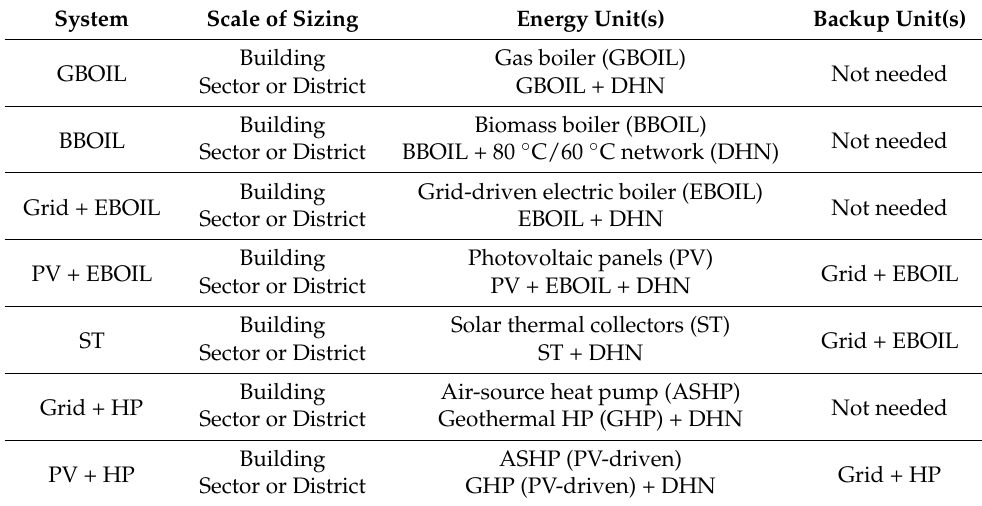
Table 1. Production systems considered in this study and their main